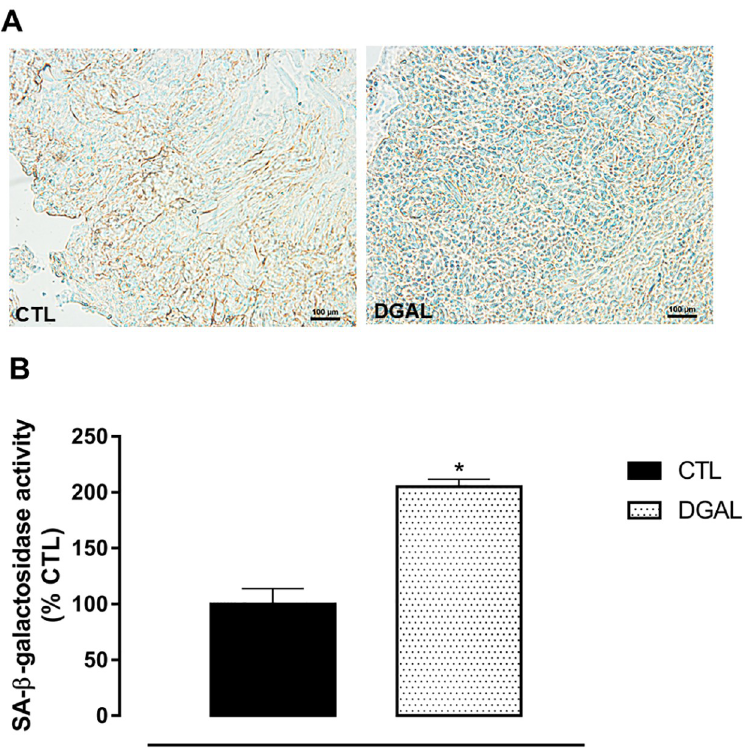
Fig 6. Representative image (A) and quantitative analysis (B) of SA- β -galactosidase activity (%) relative to the CTL group in the corpus cavernosum (5 μ M) isolated from rats, at eight weeks of treatment (20x objective). Groups: CTL (vehicle); DGAL (D-(+)-galactose 150 mg/Kg). Scale bars, 100 μ m. The data are expressed in mean percentage values (activity) in relation to the control ± SEM (n = 4). The data were analyzed using the Student’s t-test. � p < 0.05 vs